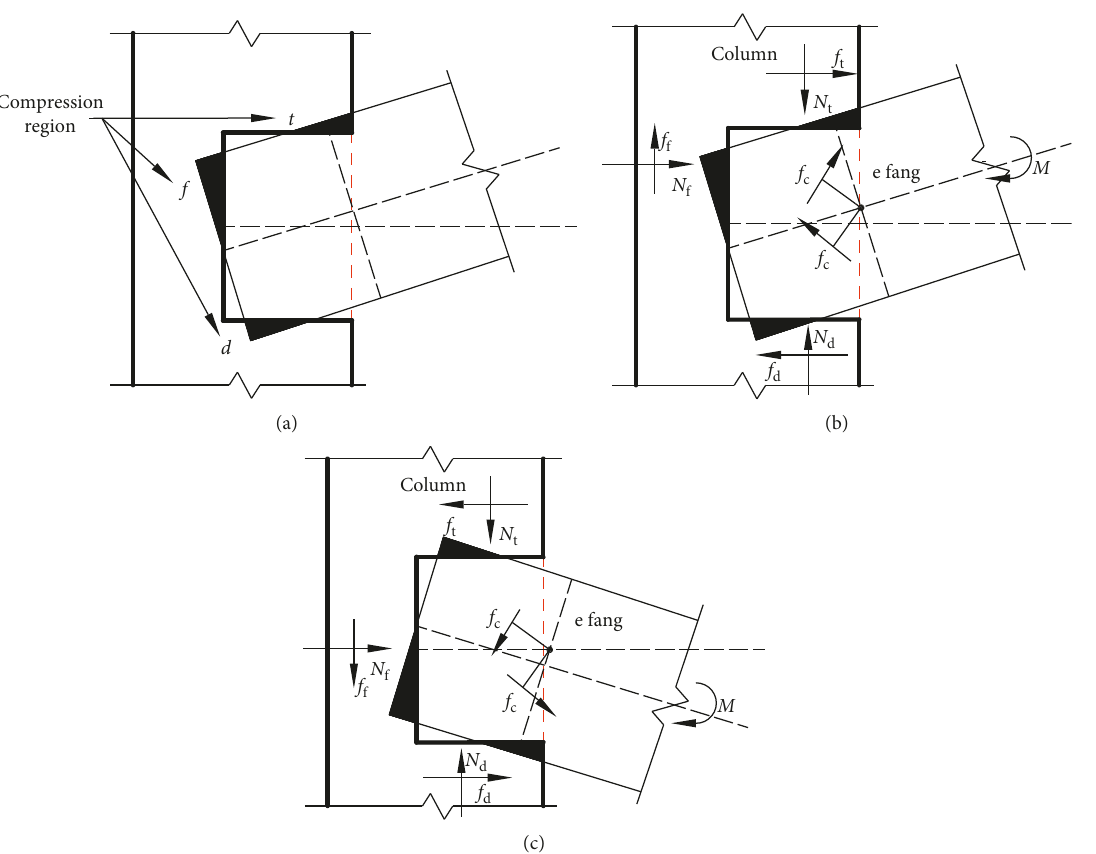
Figure 3: Forces on mortise and tenon joints under horizontal displacement of frame: (a) tenon compression zones, (b) upward loading, and (c) downward loading.